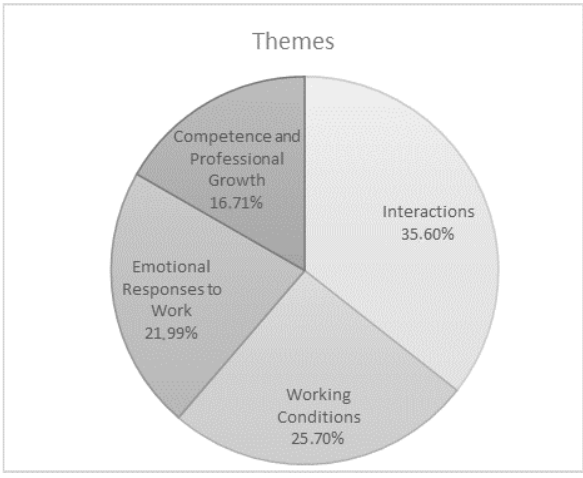
Figure 3. Risk and protective factors of well-being at work.